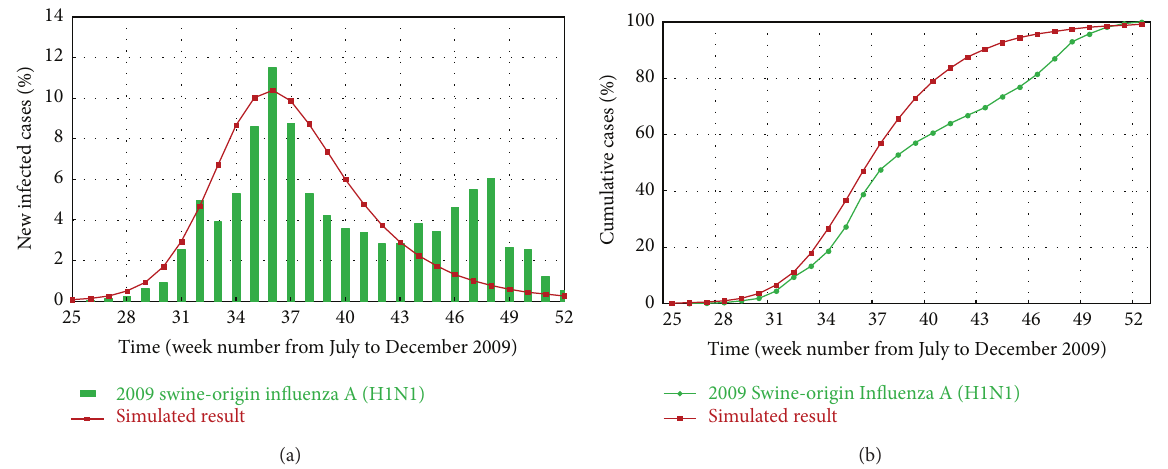
Figure 9: Comparison of actual and simulated results for (a) weekly new infected cases and (b) cumulative cases normalized for 2009 swine- origin influenza A (H1N1).